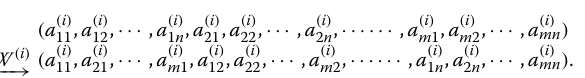
( i ) ( i ) ( i ) , a , a , ··· , a 1 n 21 22